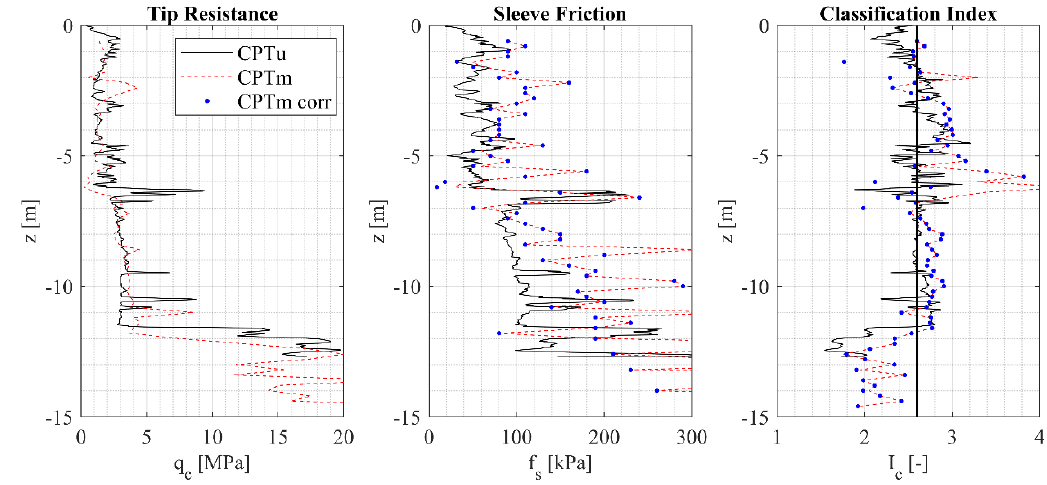
Figure 13. q c (z), f s (z) , and I C (z) profiles (CPTu 13, CPTm 6, and CPTm 6 corrected, Vicchio site).